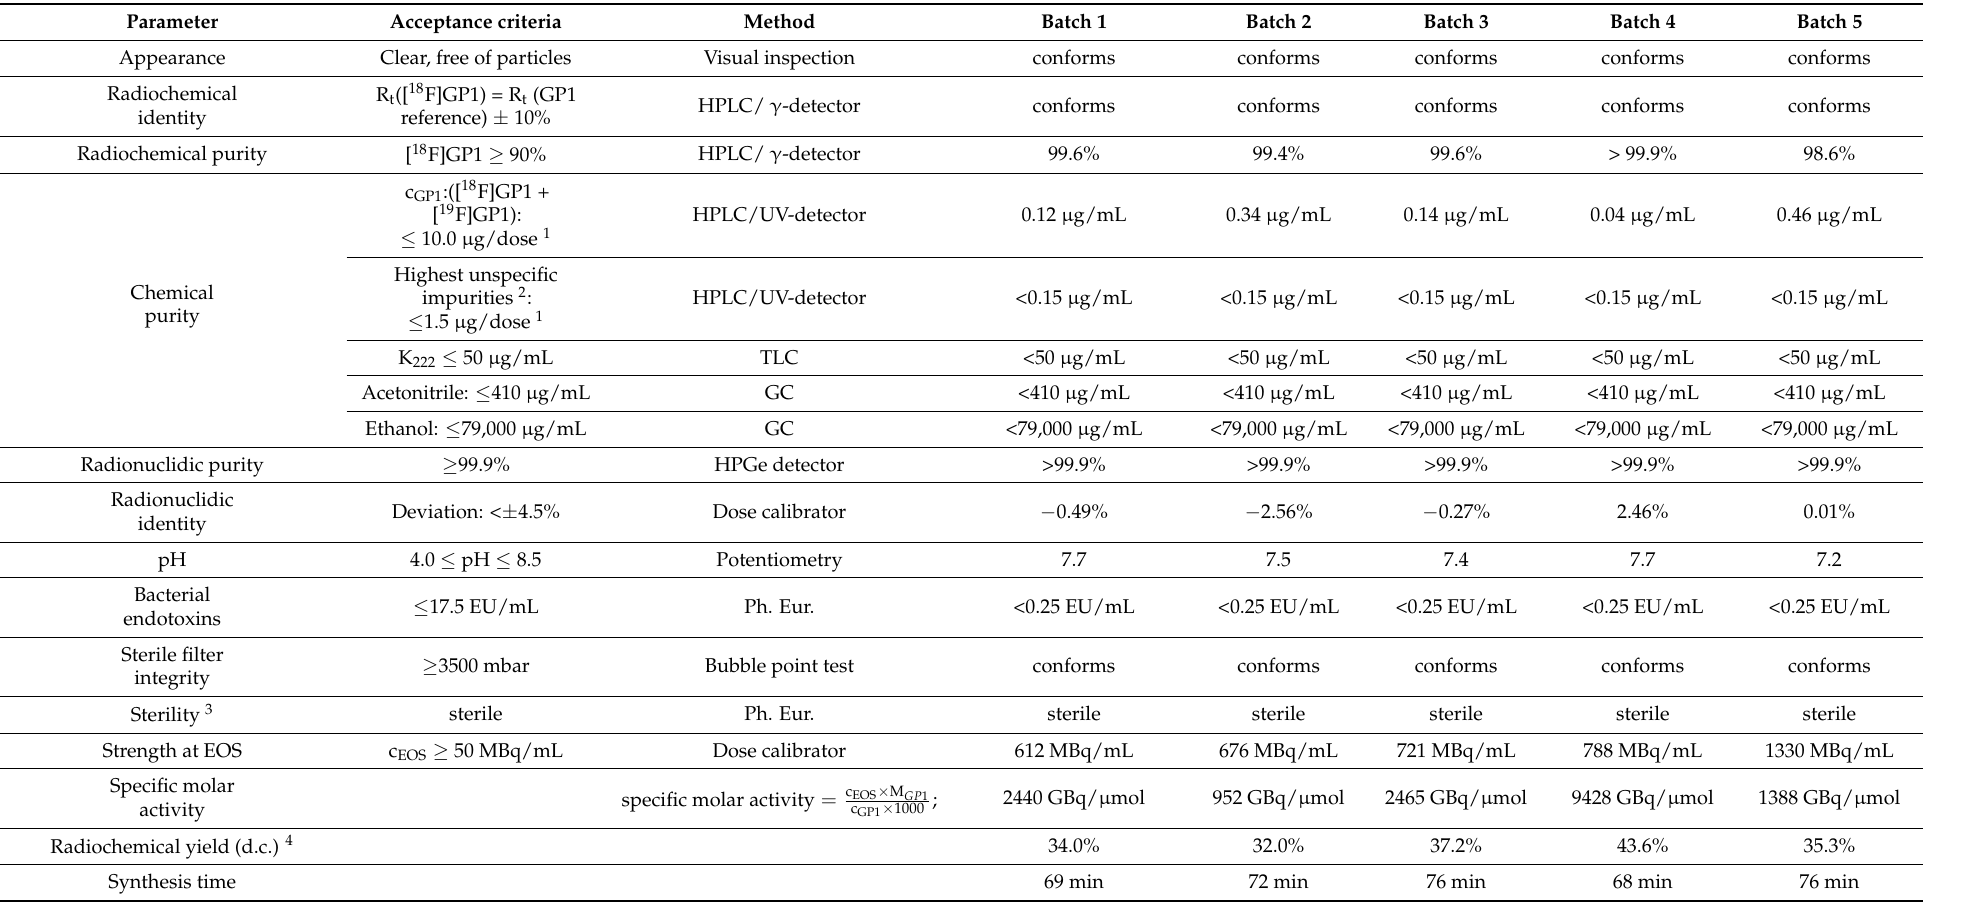
Table 1. Results of the process validation for the clinical preparation of [ 18